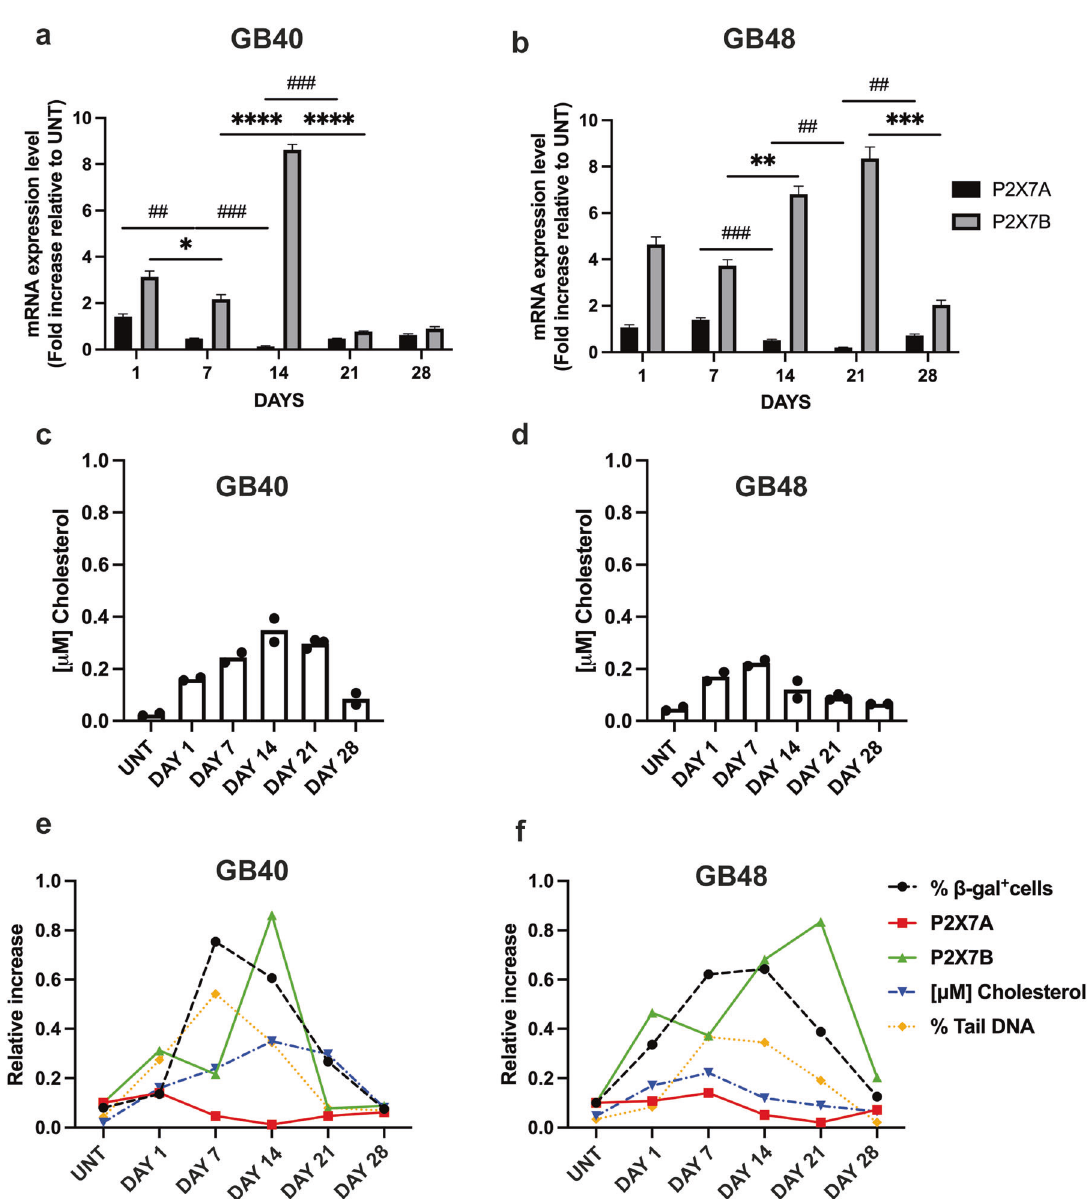
Fig. 6 Changes in P2X7A and P2X7B isoform expression and cholesterol content in radiation-resistant GBM clones during recovery. a mRNA expression levels of P2X7A and P2X7B isoforms in GB40 cells at increasing intervals radiation treatment. Data were normalized to HPRT-1 and GAPDH housekeeping genes. Data are shown as mean ± SEM; n = 3. b mRNA expression levels of P2X7A and P2X7B isoforms in GB48 cells at increasing intervals after radiation treatment. Data were normalized to HPRT-1 and GAPDH housekeeping genes. Data are shown as mean ± SEM; n = 3. c , d Total cellular cholesterol content measured at increasing intervals after radiation treatment. Single data are reported, n = 2. e , f Correlation between P2X7A/B mRNA expression levels, DNA damage (expressed as percent tail DNA), senescence marker (expressed as percent β -gal positive cells), and the total amount of cholesterol at increasing intervals after radiation treatment. Statistical analyses were conducted with unpaired two-tailed Student ’ s t -test. P values: * P ≤ 0.05; ** P ≤ 0.01; *** P ≤ 0.001; **** P ≤ 0.0001; ## P ≤ 0.01; ### P ≤